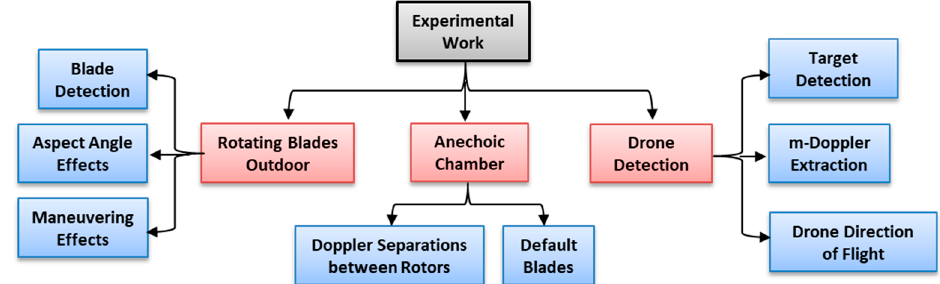
Figure 5. Micro-Doppler and drone detection experimental analysis and scenario set-up in FSR (Forward Scattering Radar) system.